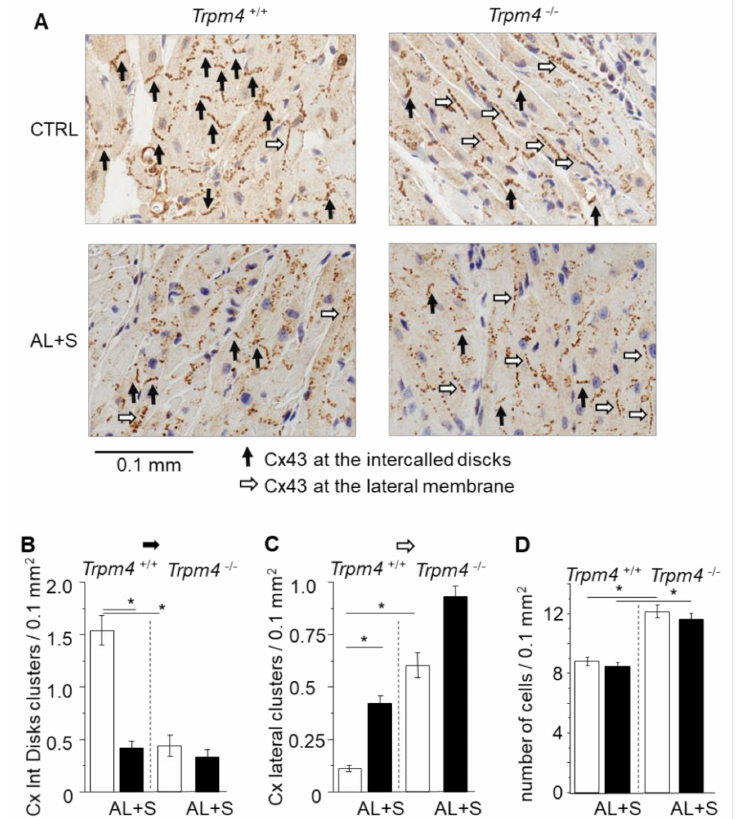
Figure 4. Organization of Connexin 43. ( A ) Representative immunolabelling of Cx43 (brown) in paraffin fixed embedded left atria sections (6 µ m thickness) from Trpm4 +/+ and Trpm4 -/- animals after 28 days of treatment with or without aldosterone + salt. Hematoxylin labelling (nucleus in blue). Black arrows indicate organized Cx43 complexes at the junctional plaques between two adjacent cardiomyocytes. White arrows indicate organized Cx43 complexes at the lateral membrane of cardiomyocytes. ( B ) Mean density of organized Cx43 complexes at the intercalated disks (organized Cx/0.1 mm 2 ) ( n = 20 to 50; N = 2 to 6 as indicated in the text). ( C ) Mean density of organized Cx43 complexes at the lateral membranes (organized Cx/0.1 mm 2 ) ( n = 20 to 50; N = 2 to 6 as indicated in the text). Aldosterone treatment as well as Trpm4 -/- disruption induce Cx43 disorganization. ( D ) Mean cell density for each group ( n = 20 to 50; N = 2 to 6). Statistical significance between groups are indicated by